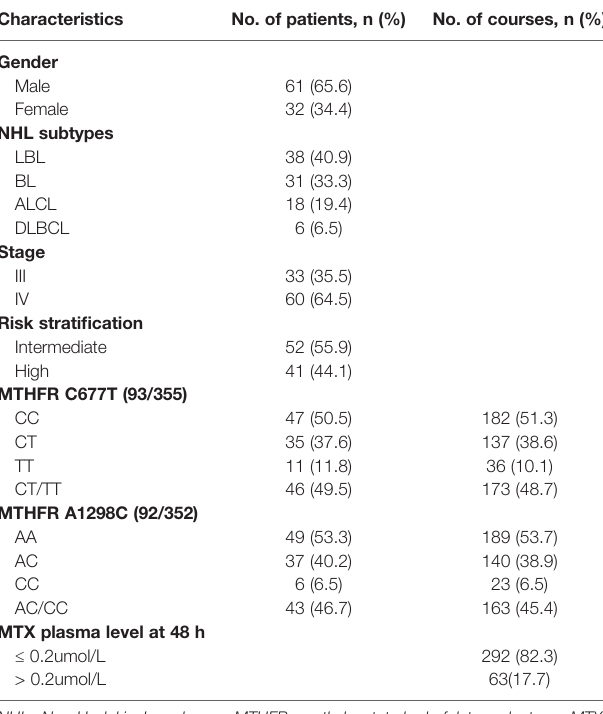
TABLE 1 | Clinical characteristics of the investigated pediatric patients with NHL (n = 93). Characteristics